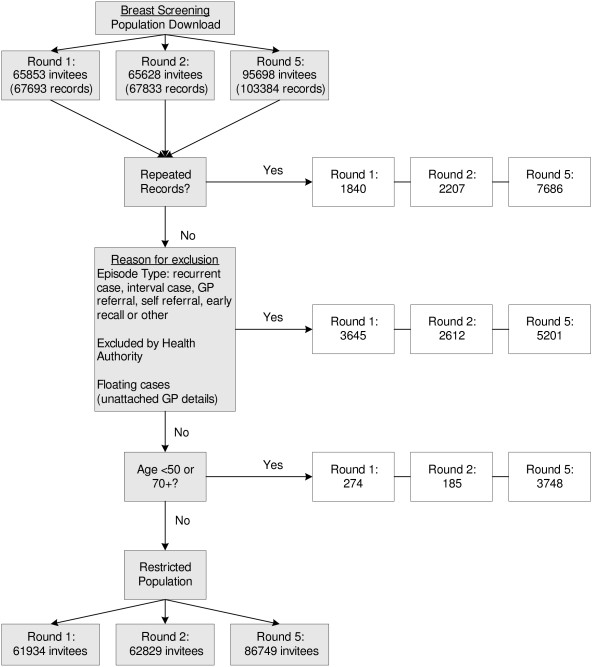
Flowchart detailing process for obtaining breast screening populations for analysis.